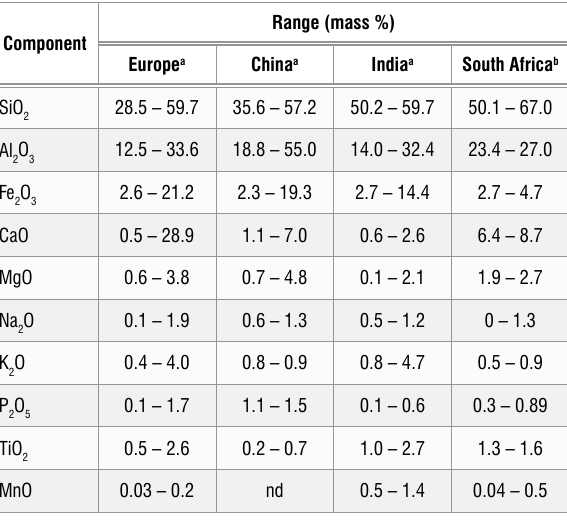
Table 1: Typical chemical concentrations of major elements as oxides in different fly ashes as analysed using X-ray fluorescence